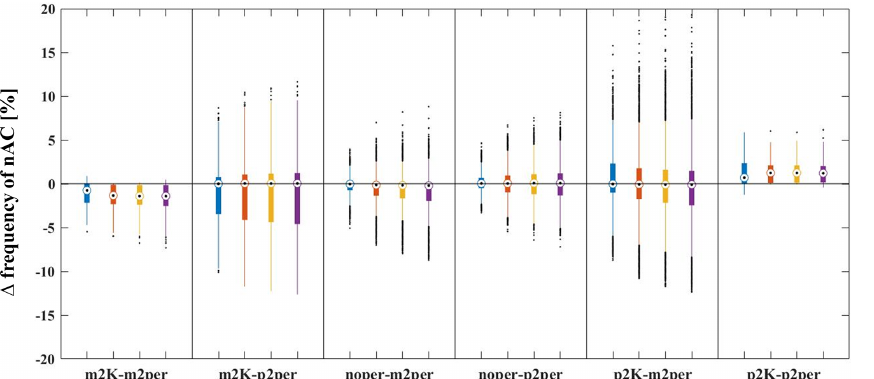
Figure 3. Changes in frequency of non-atmospherically controlled (nAC) days in response to different combinations of temperature and moisture changes in the core modification set. m2K denotes a cooling by 2K at the surface, p2K a warming of 2K at the surface, m2per denotes a drying of 2 times the scaling factor, and p2per denotes a moistening of 2 times the respective scaling factor in the domain for